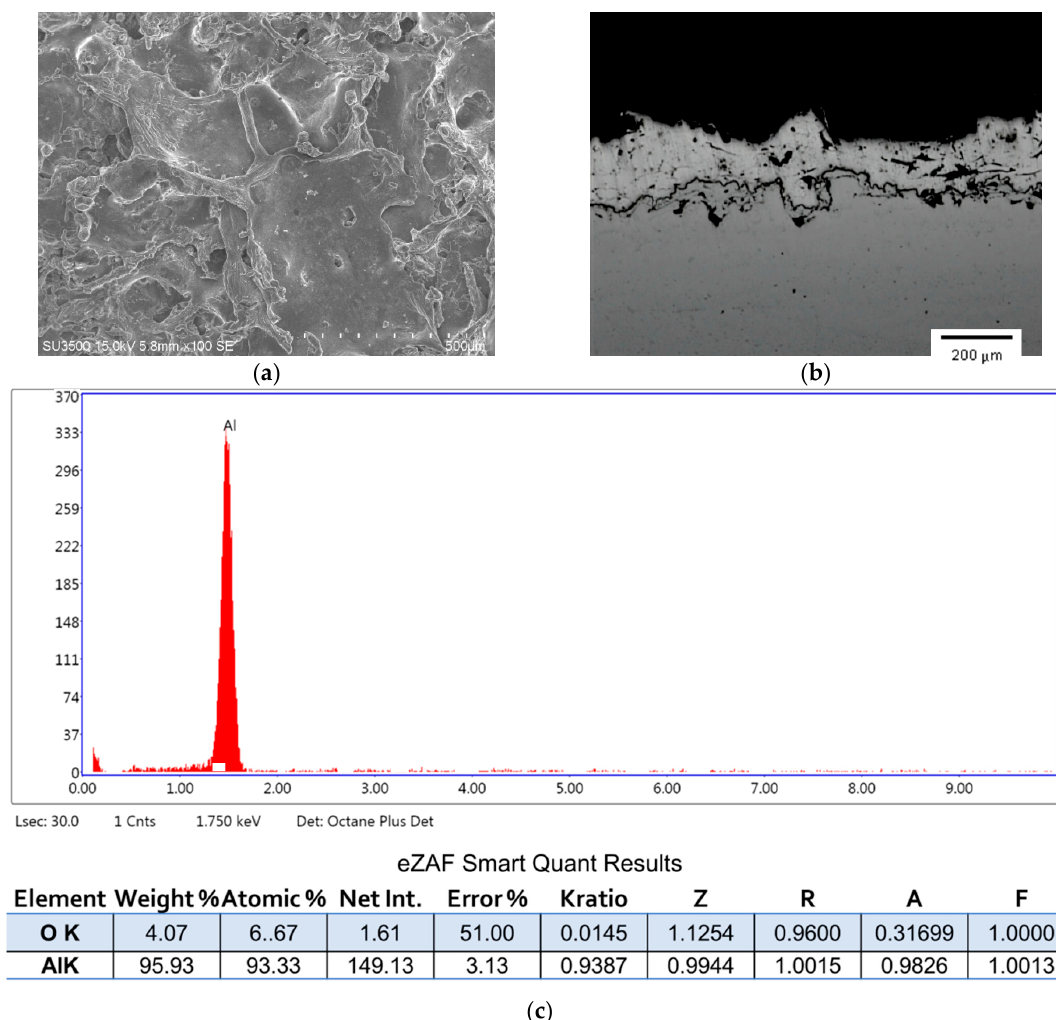
Figure 1. The surface characteristic of plasma-sprayed Al ( a ) surface and ( b ) subsurface; ( c ) The surface characteristics of energy dispersive X-ray spectroscopy (EDX).